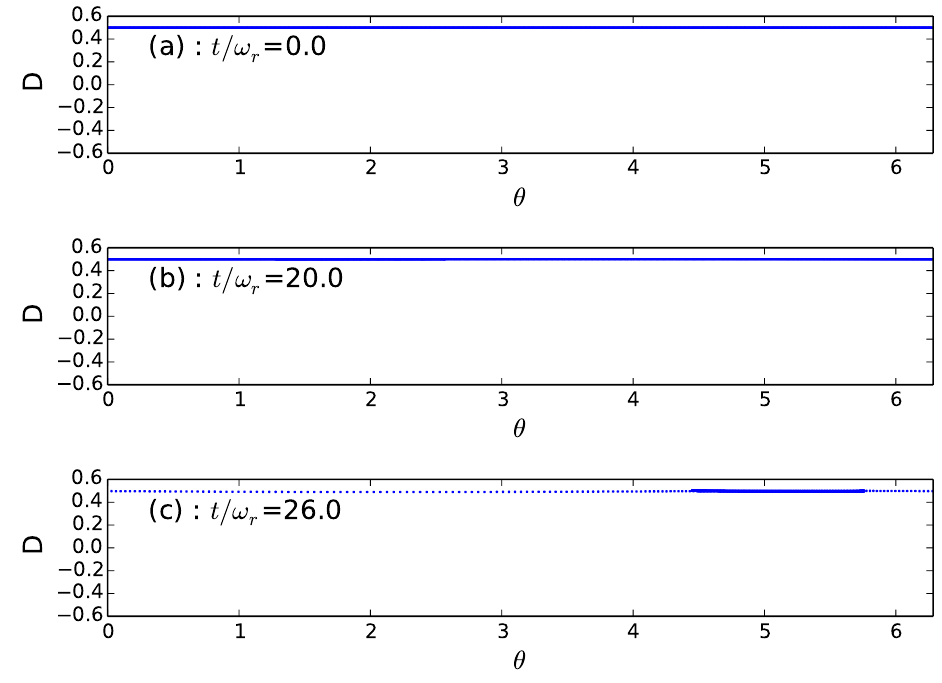
, D ) for each atom j = 1 .. 1000 j j , ( b ) t = 20 ω − 1 and ( c ) t = 26 ω − 1 in the case of weak excitation. The r r r